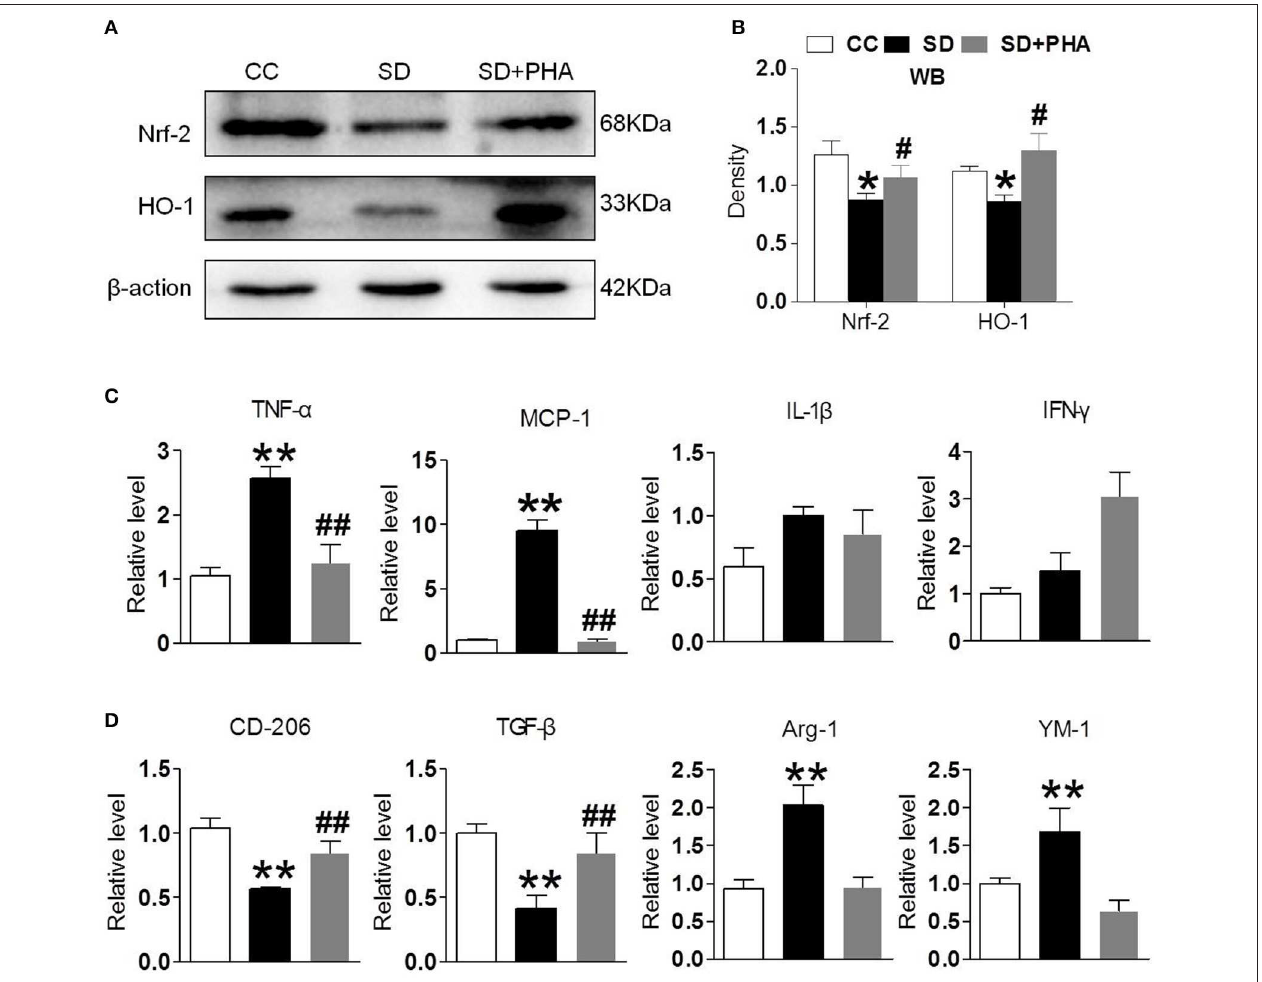
FIGURE 4 | Activated α 7-nAChR-PI3K/AKT/GSK-3 β alleviates inflammatory response and oxygen stress induced from chronic sleep deprivation. (A,B) Western blot showed expression of Nrf-2, HO-1 in the hippocampus after PHA-543613 treatment in chronic sleep deprivation. Chronic sleep deprivation inhibited the expression